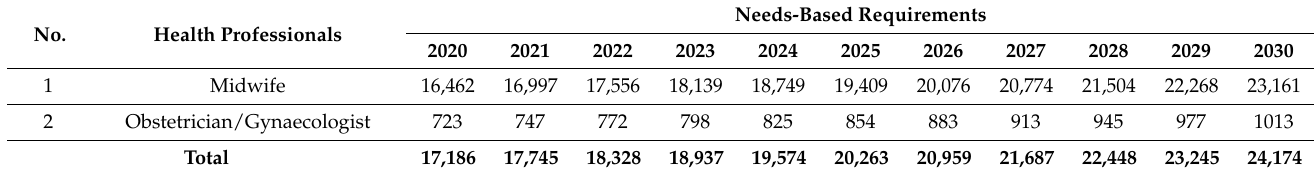
Table 1. Needs-based requirements for midwives, and obstetricians and gynaecologists.